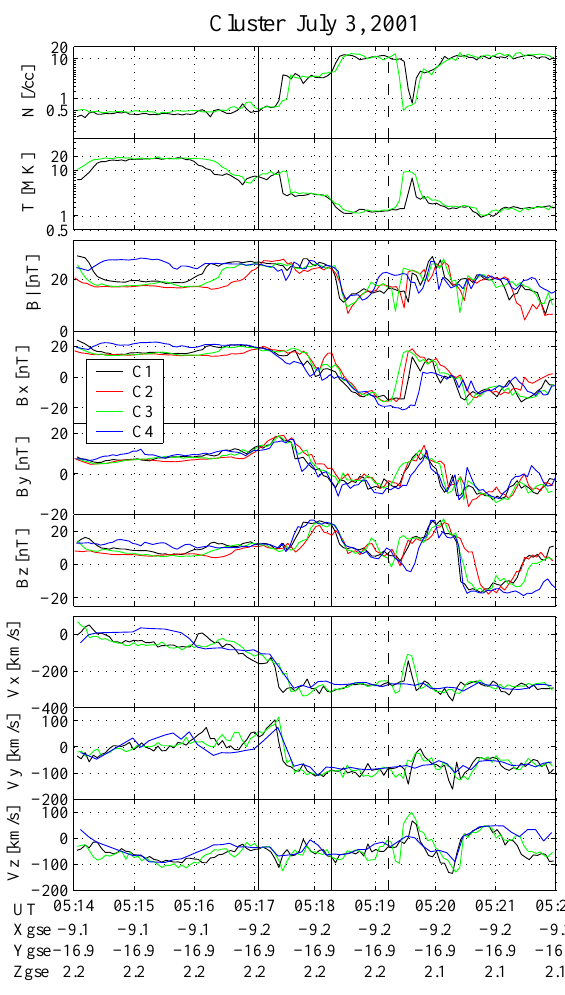
Fig. 1. Time series of Cluster measurements around a magne- topause boundary layer traversal at ∼ 05:17:30UT on 3 July 2001. The panels, from top to bottom, show ion number density, ion tem- perature, magnitude and three GSE components of the magnetic field, and three GSE components of the ion bulk velocity, respec- tively (black: spacecraft 1 (C1), red: C2, green: C3, blue: C4). The interval sandwiched between the two vertical solid lines (interval 1) is used for generating the map shown in Fig. 5, while the interval sandwiched between the first solid line and the dashed line (interval 2) is for the map in Fig.